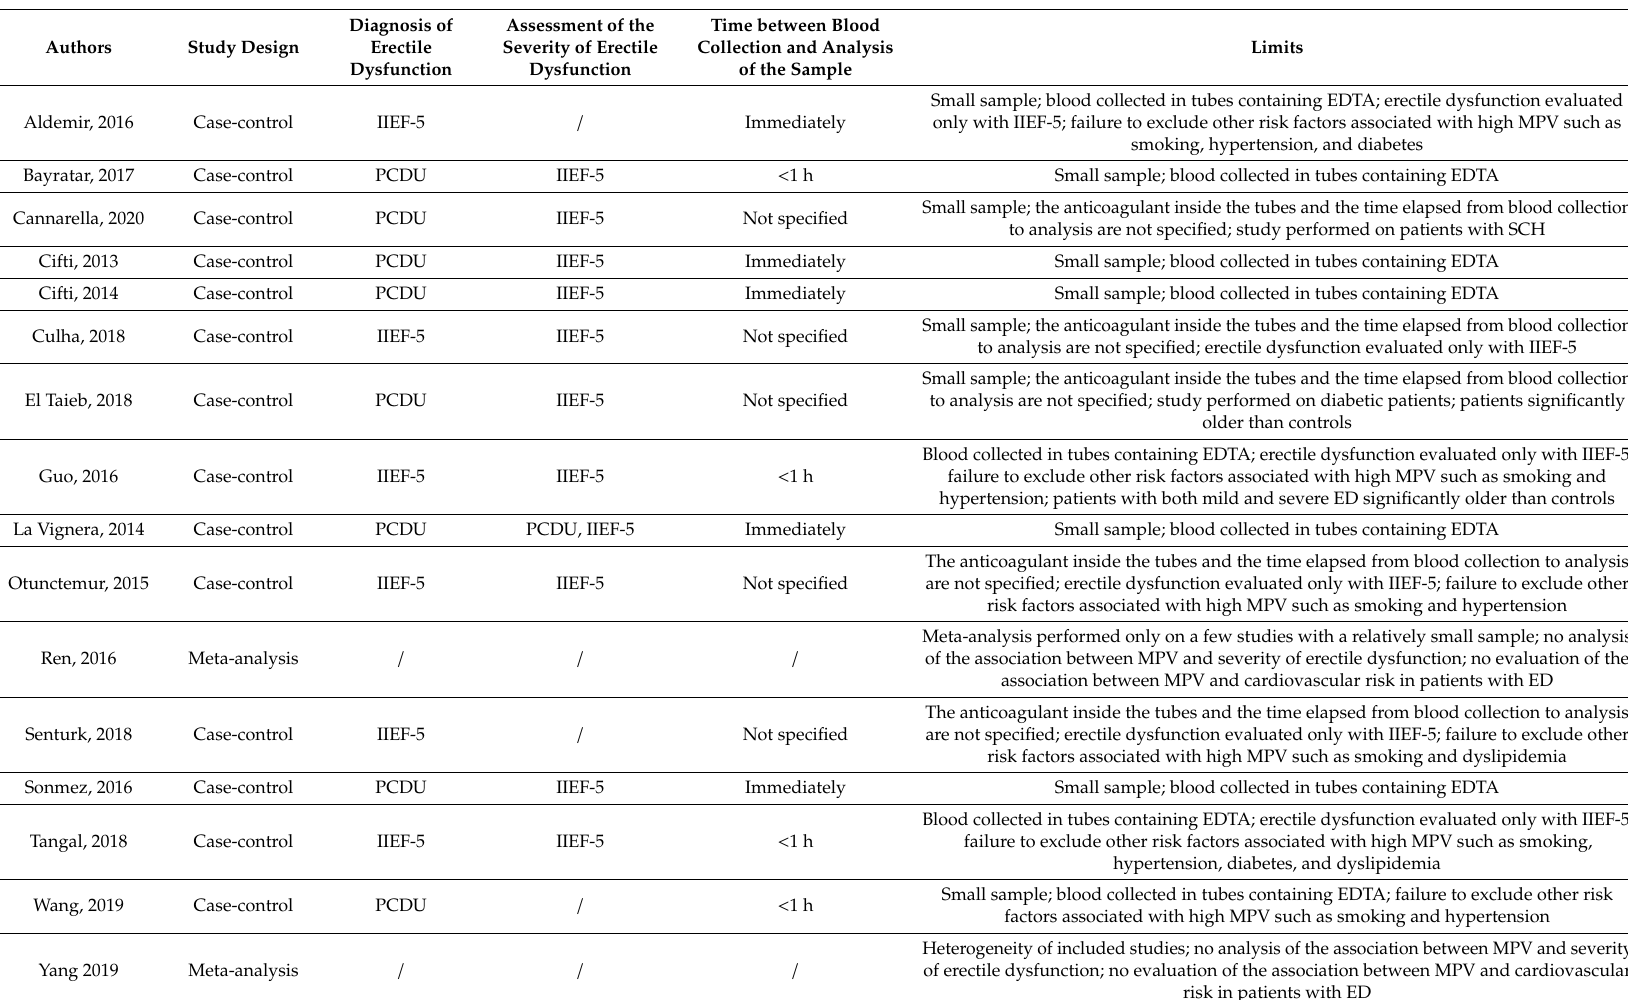
Table 2. Main characteristics and limits of the studies evaluating the role of MPV in patients with erectile